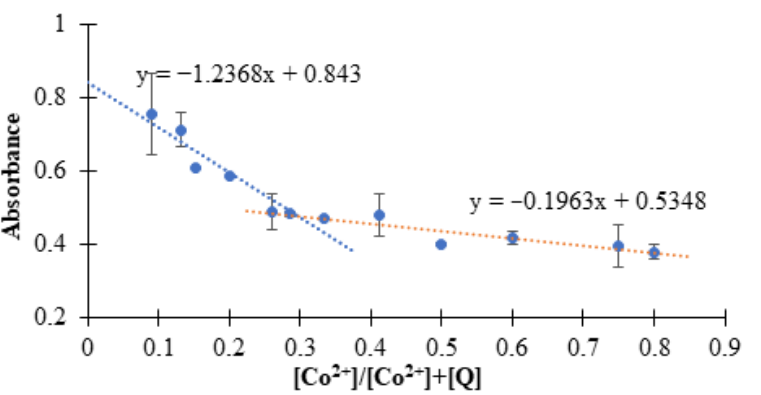
Figure 4. Curve of the dependence of the maximum absorbance in the UV/Vis electronic spectra on the composition of the cobalt(II)-quercetin complex registered in Tris-HCl buffer (pH = 7.4). The analysis of infrared spectra of the cobalt with quercetin complex indicates the participation of the carbonyl group and the hydroxyl group, from the B ring, in the formation of the complex. Moreover, the decrease in the absorbance of band I and II in the UV/Vis spectra of the complex also suggests the participation of catechol moiety and the carboxyl group in metal ion bonding [40]. Having taken into account the results of the elemental analysis (1:2 molar ratio of metal:ligand), the proposed structure of Co(II)-quercetin is shown in Figure 5. The central ion attaches two ligand molecules via chelate bonds involving the carbonyl group and the deprotonated hydroxyl group of the quercetin pyron ring. The central ion also co-ordinates the two water molecules. The way in which the ligand coordinates metal is the same as described by other authors [41]. The catechol moiety is probably engaged in the metal bonding and may therefore lead to polymeric structures being formed.